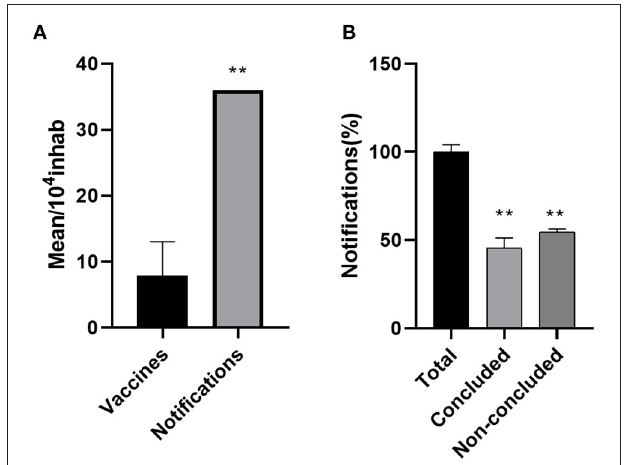
FIGURE 4 | Reports on animal bite and PEP administration in the Pará state during 2018 and 2019. (A) the offer of rabies vaccines may be insufficient to assist the PEP demand in some neglected areas of the state ** ( p < 0.01). (B) the reports on patients seeking care after a sylvatic or domestic animal bite indicate the high rate of interruption in the PEP ** ( p < 0.01).